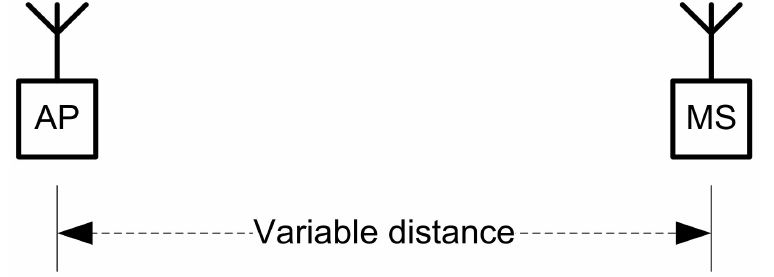
Figure 8. Setup for RX-based location